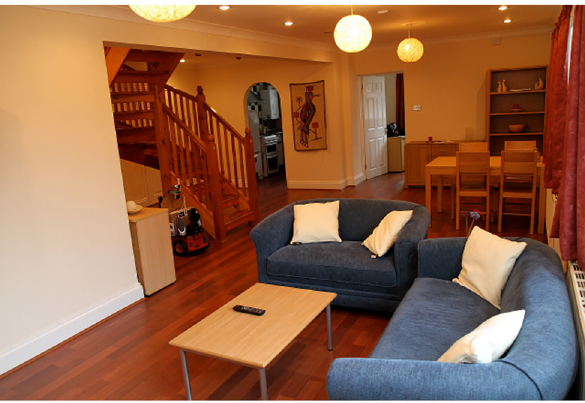
Fig 3. “ Robot House ” at the University of